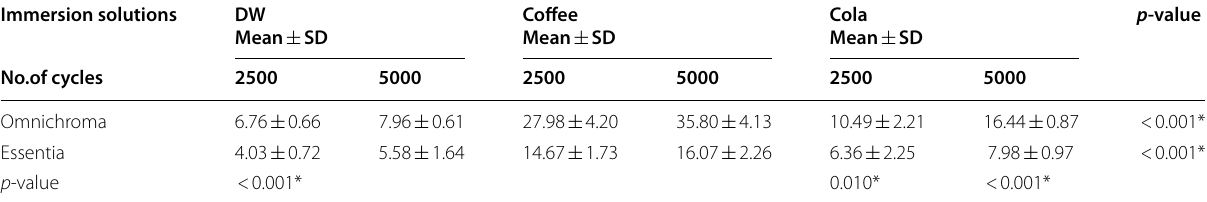
Table 2 The change in color (ΔE) values after TC 2500 and 5000 of Omnichroma and Essentia composite